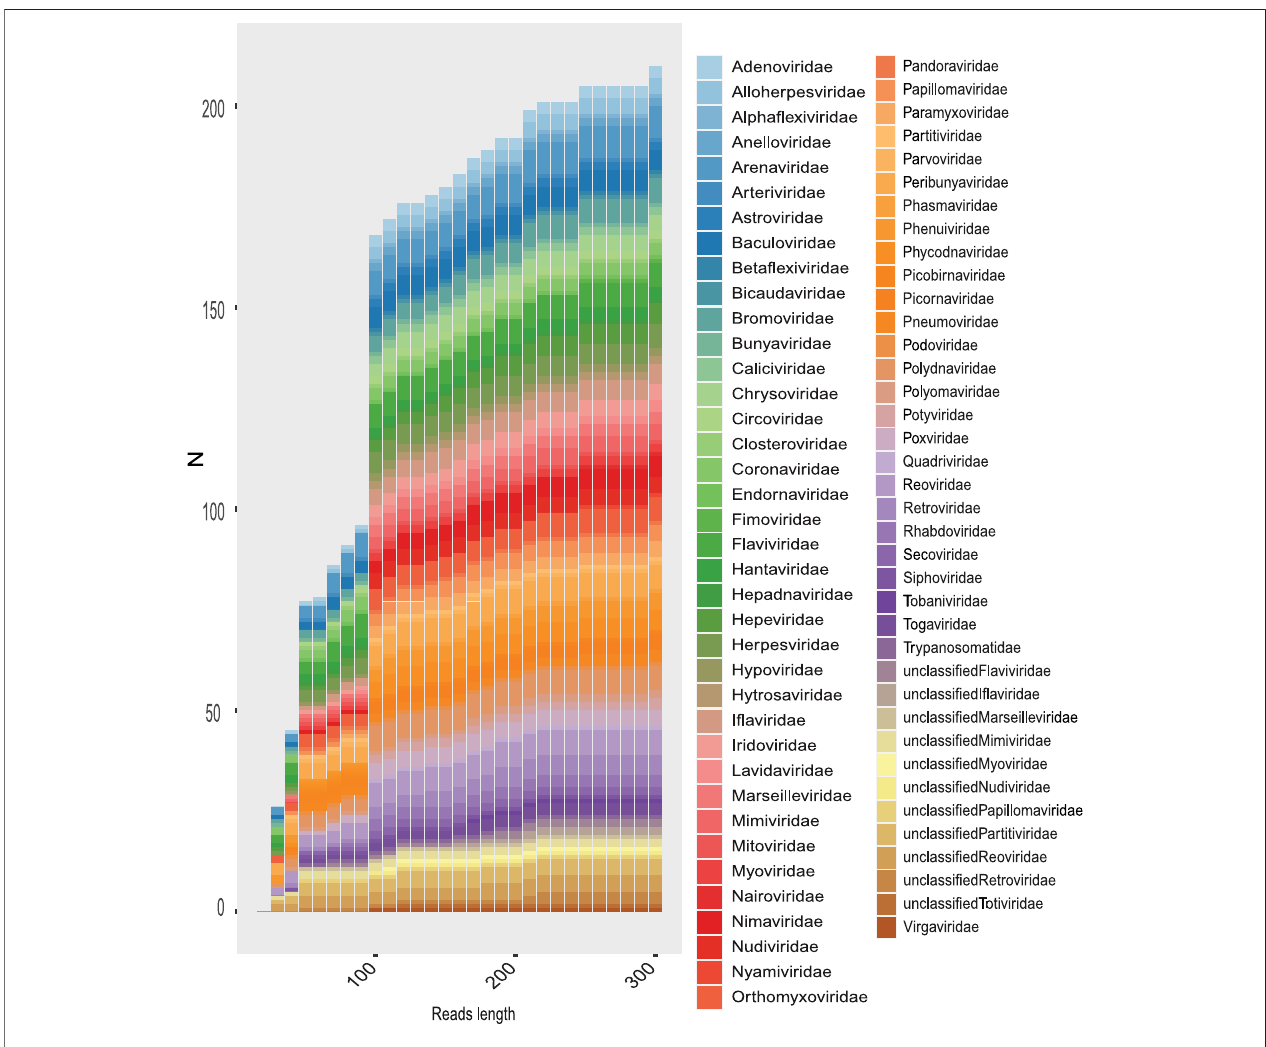
FIGURE10| Rateoffamiliesrecovered inthetotal metagenomes asthelengthofreadsisincreased. Thenumber offamiliesrecovered isshown( y -axis)according to the length of the sequence ( x -axis). The colored boxes represent the viral family.